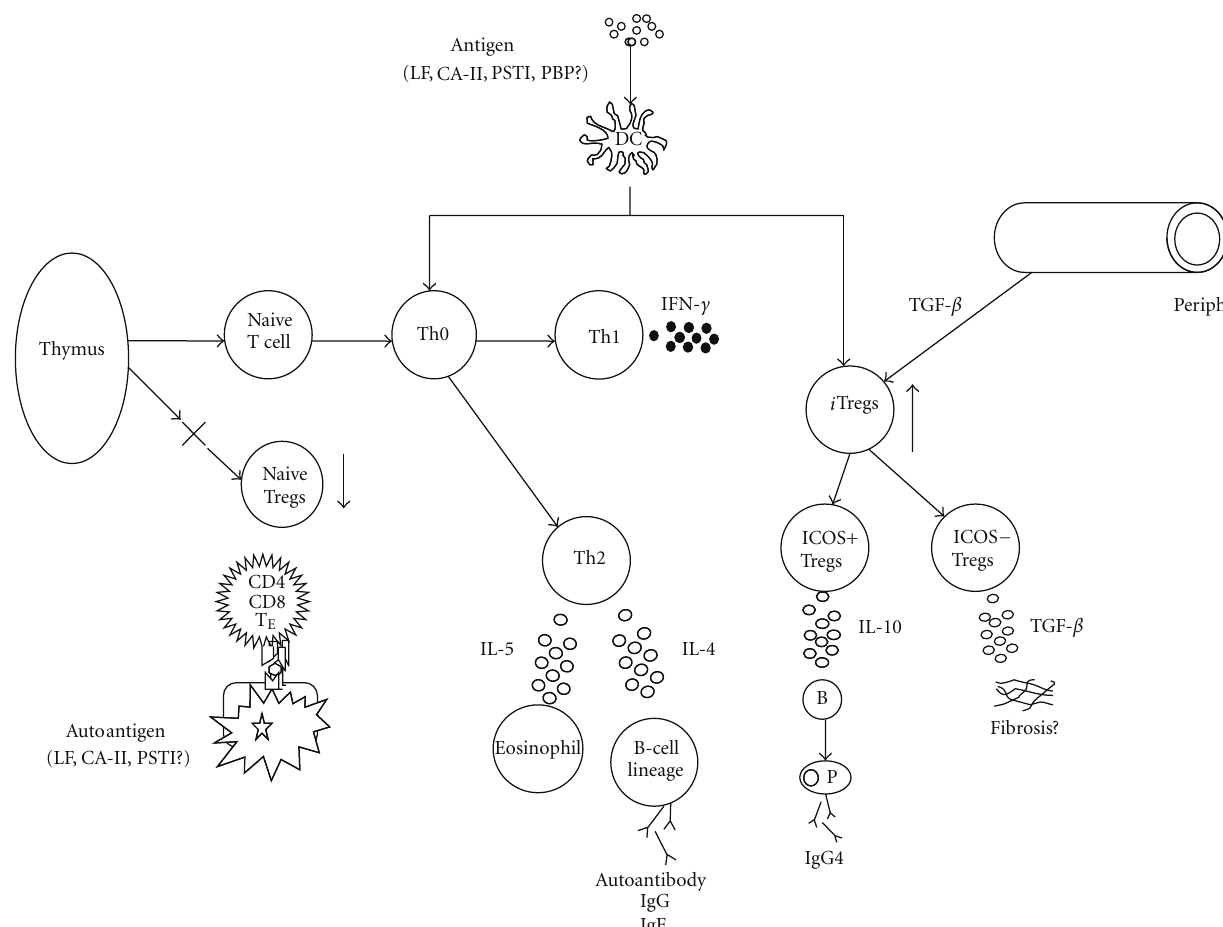
Figure 1: Hypothesis for the pathogenesis of Type 1 autoimmune pancreatitis (AIP) in IgG4-related disease. In regard to central tolerance, na¨ıve and natural regulatory T cells (Tregs) derived from the thymus suppress autoreactive CD4 or CD8 cells in the normal state. In IgG4- related disease, the basic concept is a biphasic mechanism of “induction” and “progression”. Initial response to self-antigens (e.g., lactoferrin (LF), carbonic anhydrase II (CA-II), CA-IV, pancreatic secretory trypsin inhibitor (PSTI), amylase-alpha, and plasminogen binding protein (PBP) peptide of Helicobacter pylori ) might be induced by decreased na¨ıve Tregs. Th2 immune responses are followed by a Th1-type immune response with the release of proinflammatory cytokines (interferon- γ (IFN- γ ), interleukin (IL)-1 β , IL-2, tumor necrosis factor- α (TNF- α )). Th2-type immune responses, producing IgG, IgG4, and autoantibodies may be involved in the pathophysiology of progression. The production of IgG4 may be regulated by increased IL-10 secreted from inducible co-stimulatory molecule (ICOS) + e ff ector Tregs. Fibrosis may be regulated by TGF- β secreted from ICOS − Tregs. This figure modified from Okazaki et al. [54]. DC: dendritic cell, TE: e ff ector T cell, nTreg: natural